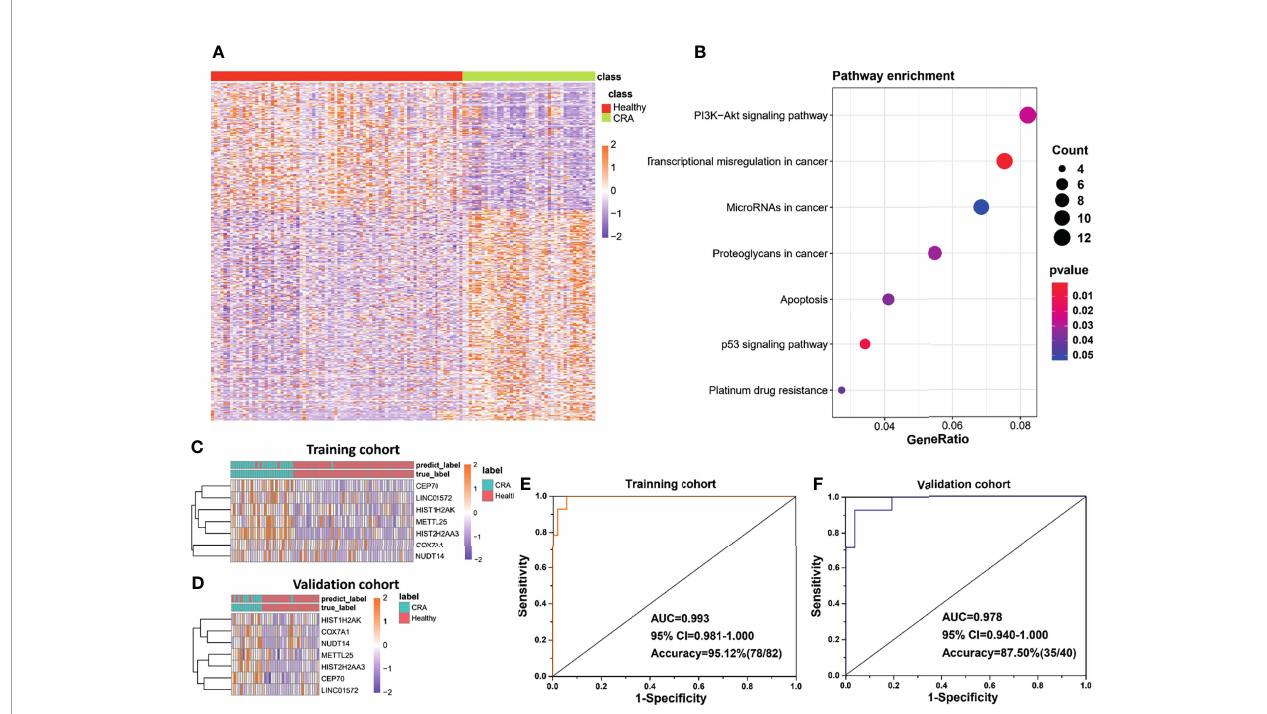
FIGURE 4 | Potential of the exLR d-signature in differentiating CRA and healthy participants. (A) Unsupervised hierarchical clustering of the differentially expressed exLRs between CRA and healthy cohorts. (B) KEGG pathway enrichment analysis for the differentially expressed exLRs between CRA and healthy cohorts. (C, D) Unsupervised hierarchical clustering of the 7 genes selected for d-signature establishment in the training cohort (C) and validation cohort (D) . (E, F) ROC curve for the exLR d-signature in the training (D) and validation (E)